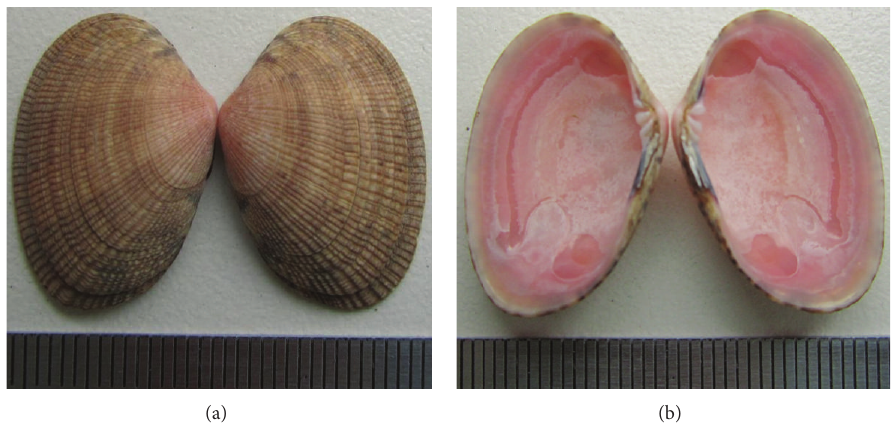
Figure 2: The external and inner surfaces of Ruditapes bruguieri